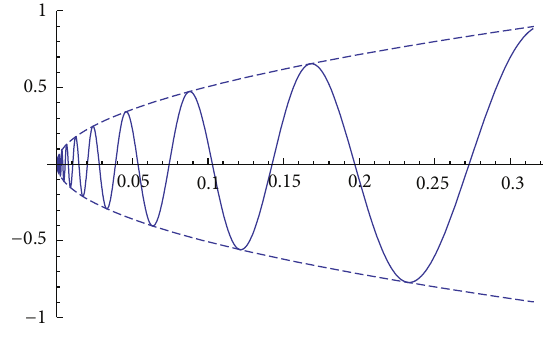
Figure 1: 𝑦 is continuous, bounded, and oscillatory near 𝑥 = 0